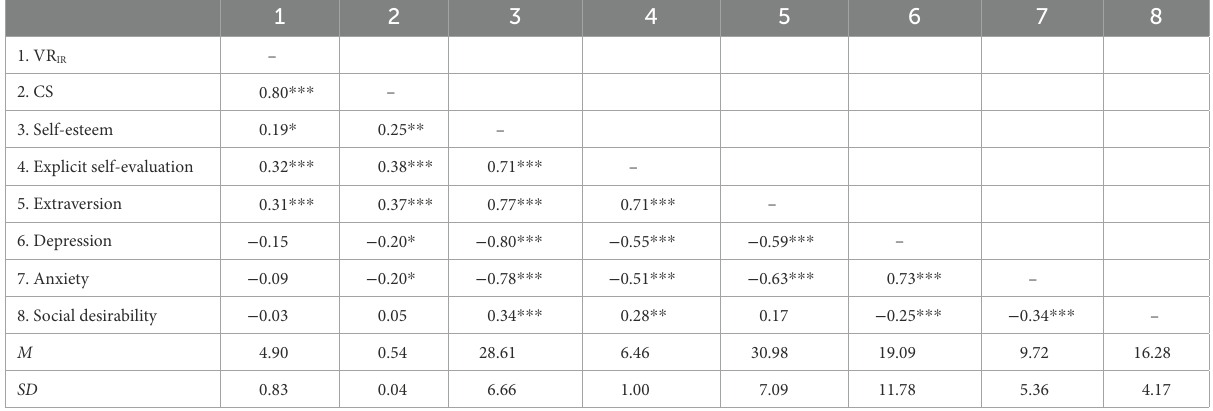
TABLE 2 Descriptive statistics and correlations between study